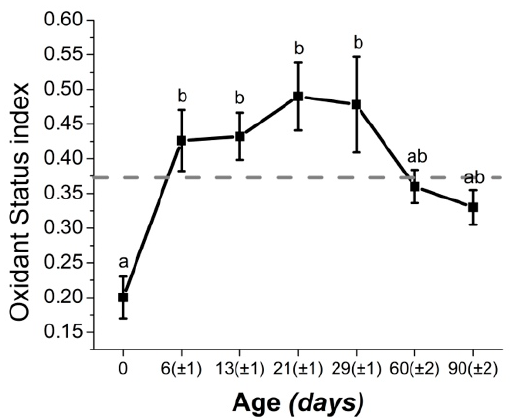
Figure 2. Values (mean ± SEM) of oxidant status index during the first months of life in dairy calves. The index is calculated as the ratio between reactive oxygen species and total antioxidant defenses. Hence, the higher the value of the index, the higher the imbalance of pro- to antioxidants. The dashed gray line represents the highest average index value found in periparturient dairy cattle. SEM: standard error of the mean. a, b Means with different letters are statistically different (P < 0.05) Figure adapted from [7].